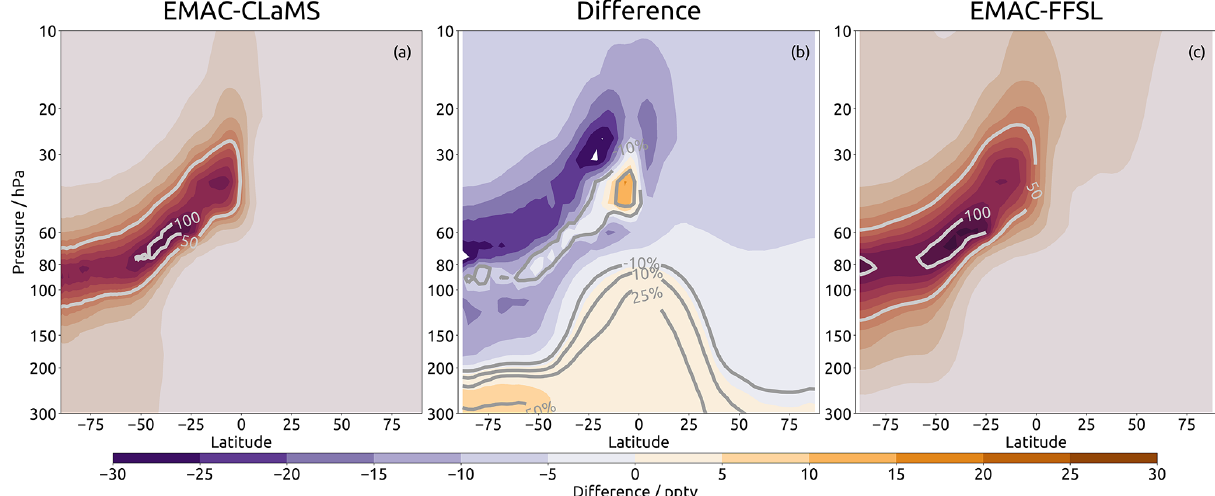
Figure 12. Zonal mean tracer distribution from continuous mass injection in the stratosphere (30 ◦ S, 100hPa) from EMAC-CLaMS (a) and EMAC-FFSL (c) results, contours showing tracer mixing ratios in parts per trillion by volume (emission value of 1ppbv). Also shown is the difference between the fields (b) with both absolute differences (shading) and percentage differences (contours, EMAC-CLaMS as reference). Results are shown for a 1-year lifetime